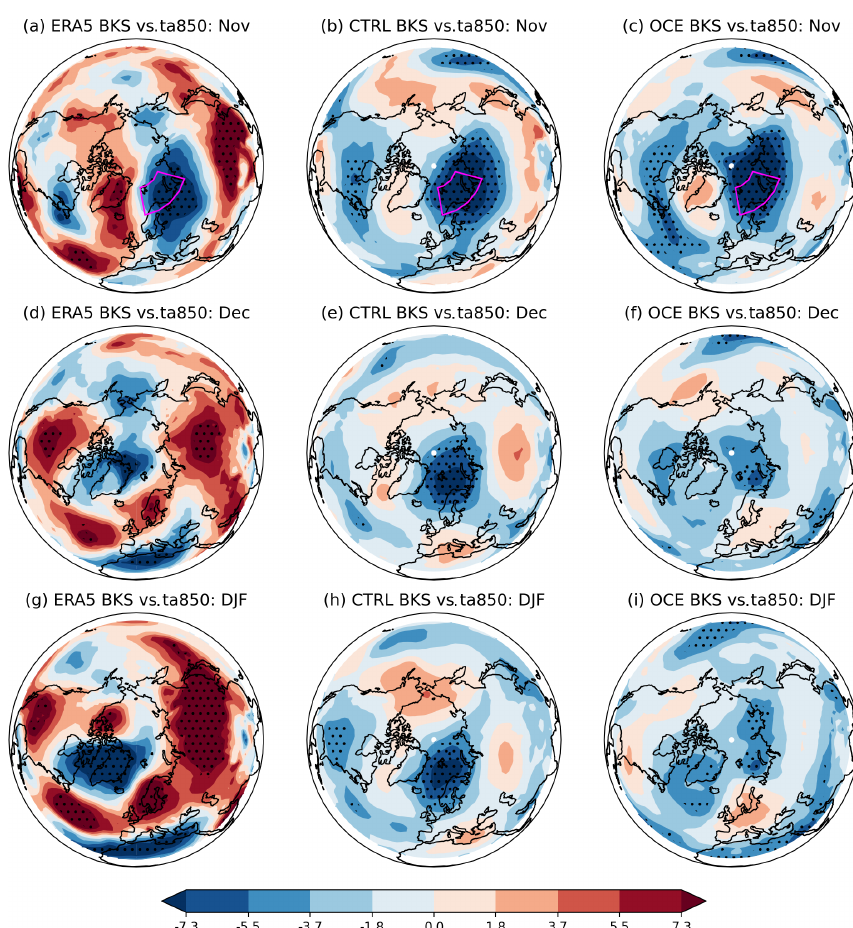
Figure B6. Regression coefficients of November BKS sea ice anomalies against monthly 850hPa temperature (ta850) anomalies at each grid point in ERA5 for (a) November, (d) December, and (g) DJF. The same for CTRL and OCE in (b) , (e) , and (h) and (c) , (f) , and (i) , respectively. The period considered is 1980–2015. Stippling highlights grid points where the associated correlation coefficient is statistically significant ( p < 0 . 05). The Barents–Kara region is shown with a purple